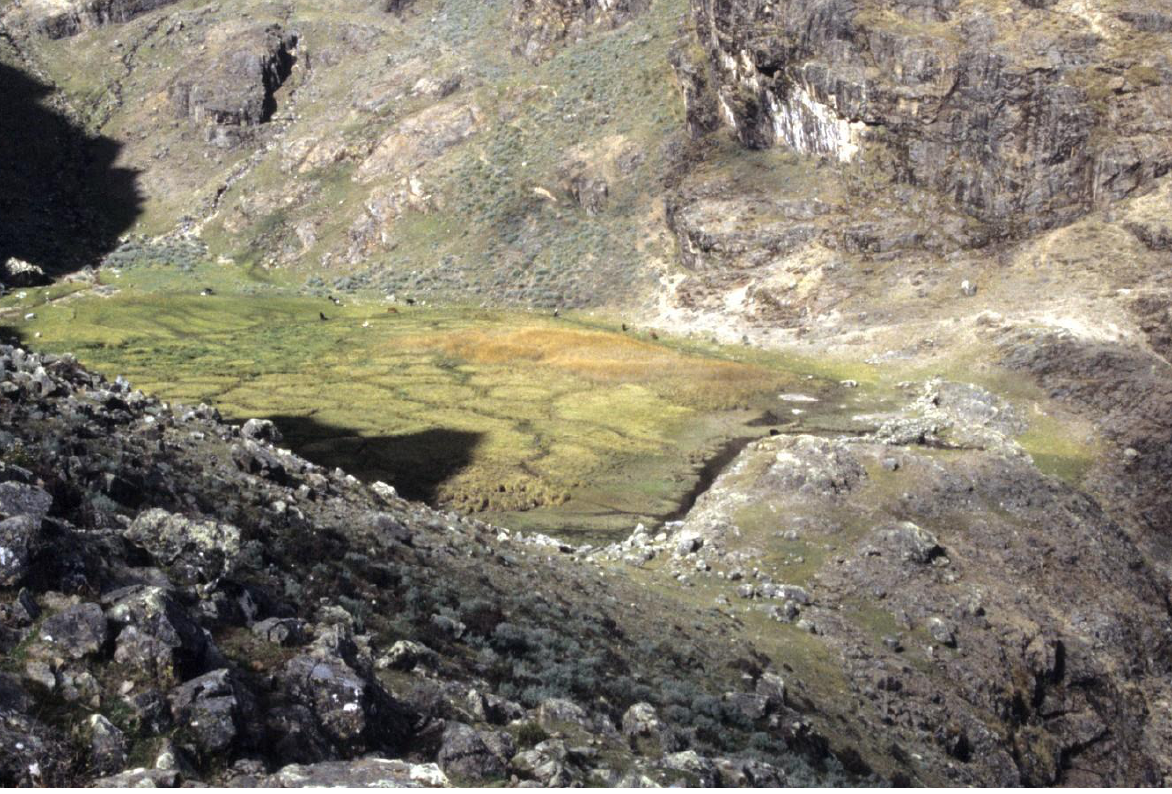
Figure 9. Huancacocha silt dam [Rac 1].